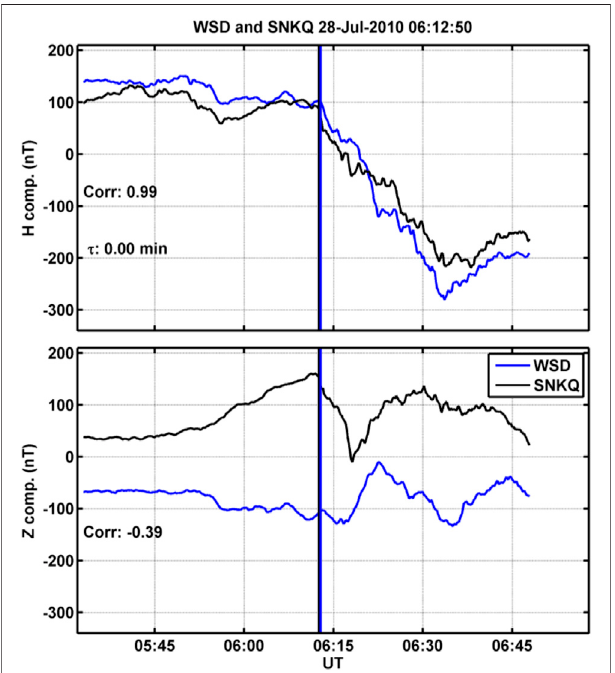
FIGURE 2 | Example of onsets that occur at different times in the southern and northern hemispheres. This fi gure has the same format as Figure1 .Inthetoppanel, thesharpdropinthe H componentofthemagnetic fi eld begins at SNKQ about 2.5 min before the WSD